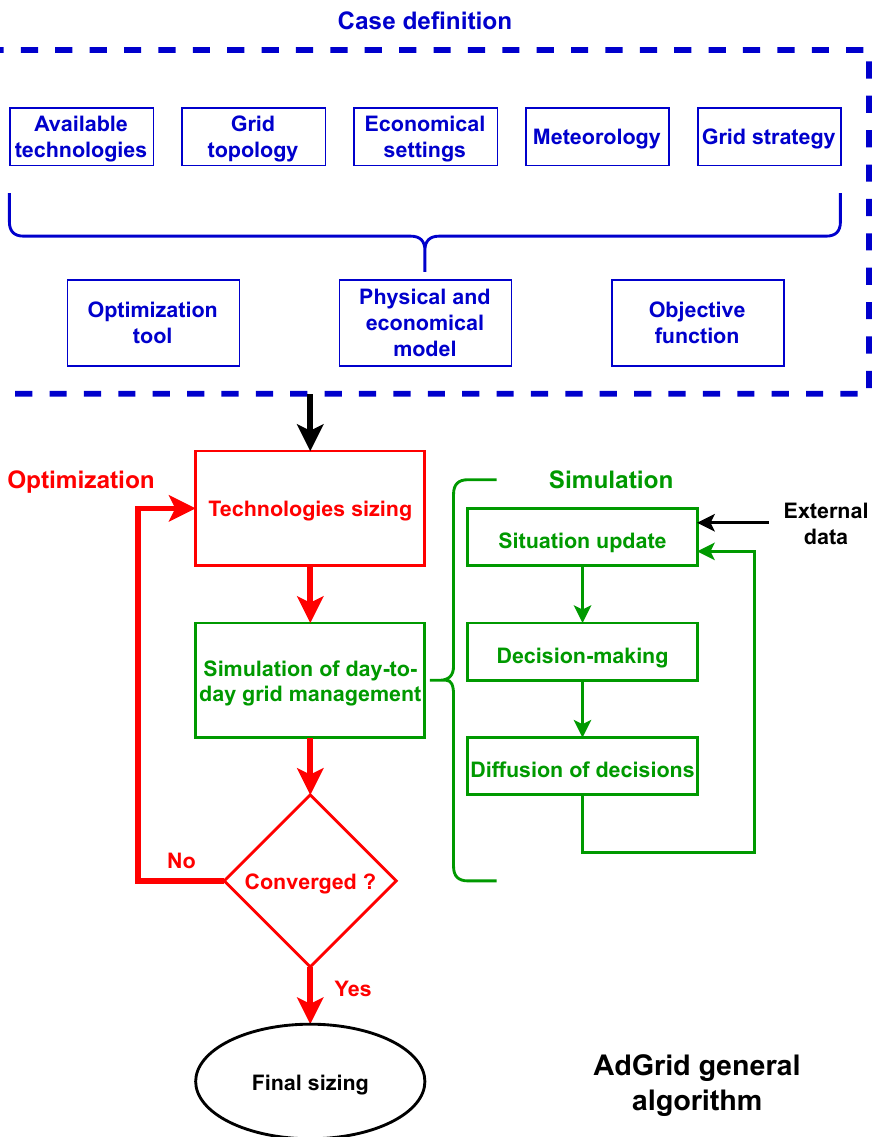
Figure 1. Algorithm